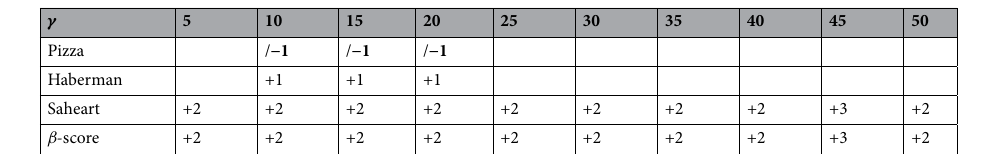
c + c − . The numbers in the